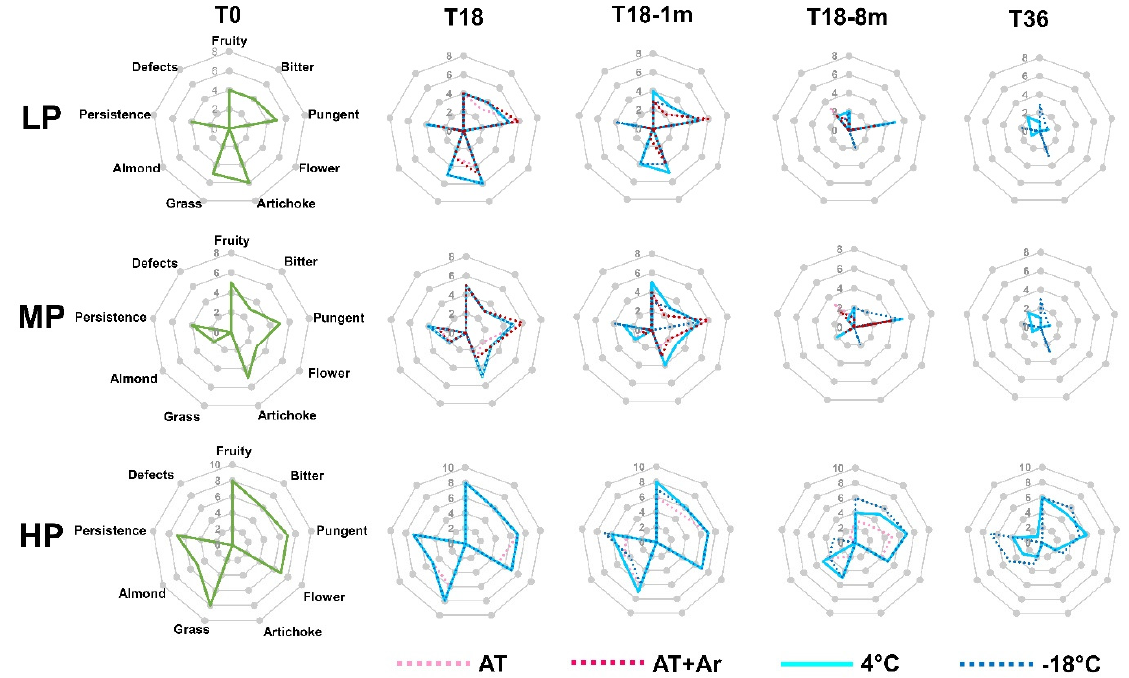
Figure 6. Radar chart reporting the median of fifteen organoleptic evaluations (three replicas X oil X panel members) carried out on EVOOs at different time points (T0, T18, T18-1 m, T18-8 m, and T36).